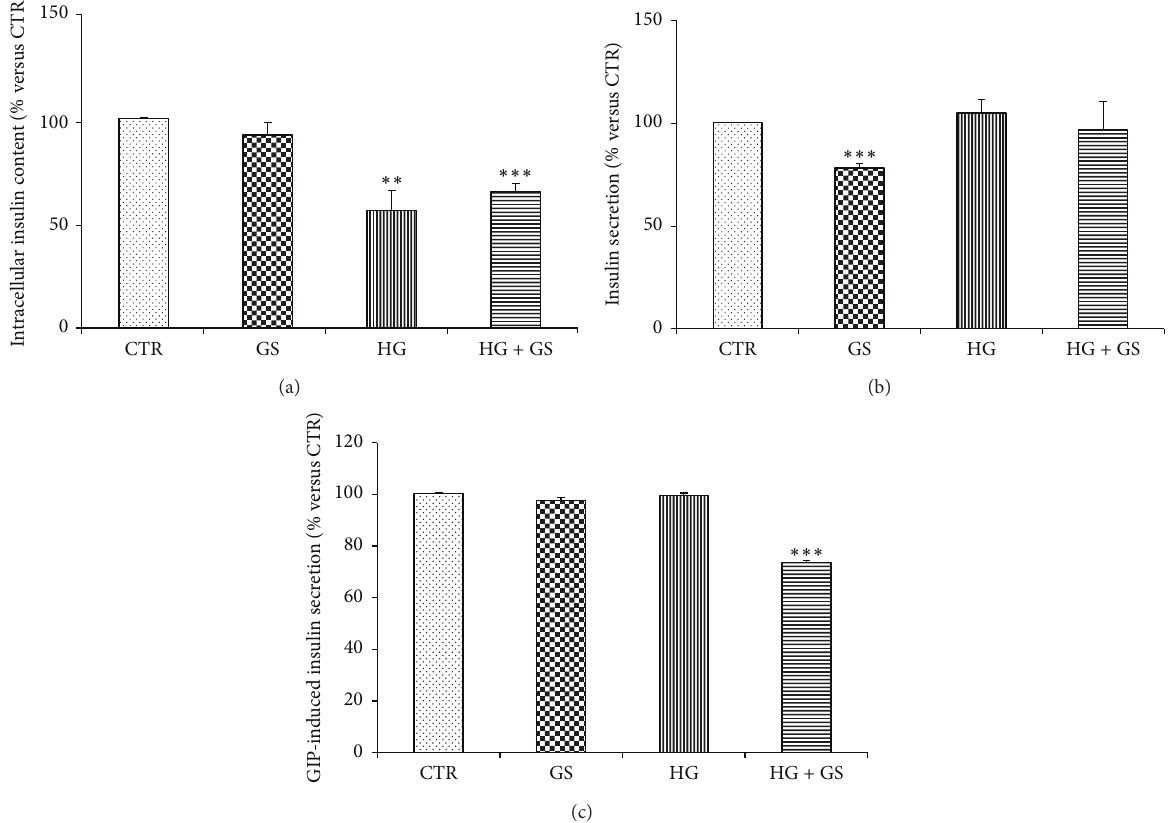
Figure 5: Treatments with GS and HG altered insulin secretion. Relative levels of intracellular insulin content (a) and insulin released in the supernatants of HIT-T15 cells challenged for 2 hours in the presence of 4 mmol/L glucose alone (b) or 10nmol GIP (c). Data are expressed as mean ± SE versus CTR ( 𝑛 = 3 ). ∗∗ 𝑃 < 0.01 and ∗∗∗ 𝑃 < 0.001 versus